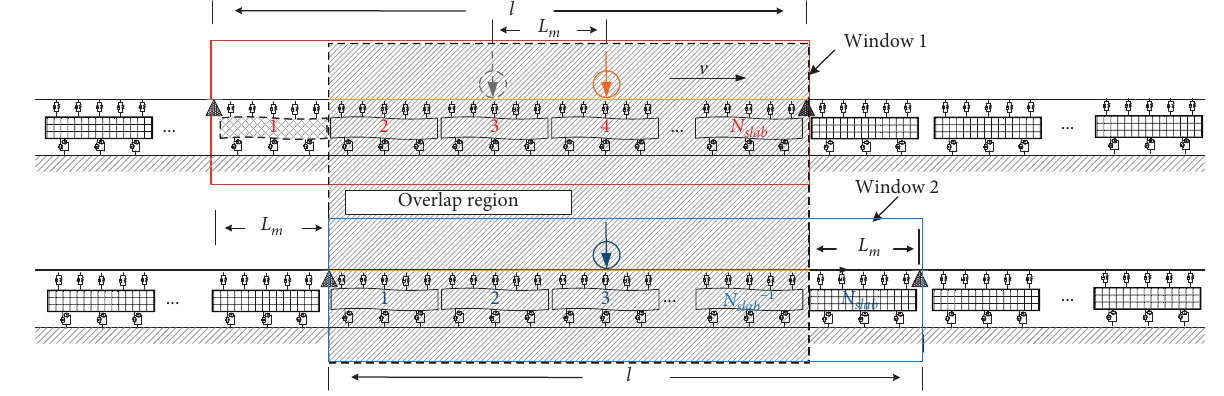
Figure 4: Transient states of the vehicle/track